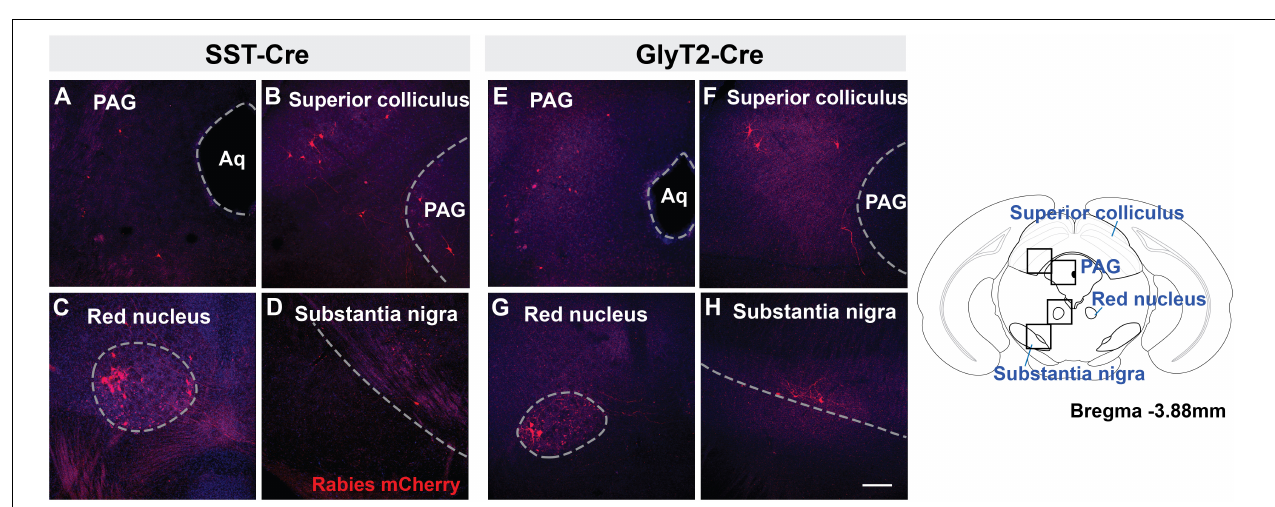
FIGURE 3 | Midbrain afferent projections of SST + (A–D) and GlyT2 + (E–H) preBötC neurons extend to the PAG, superior colliculus, red nucleus, and substantia nigra. Boxes in schematic represent location of images shown. (Aq, cerebral aqueduct; PAG, periaqueductal gray), Scale bar = 200 µ m.